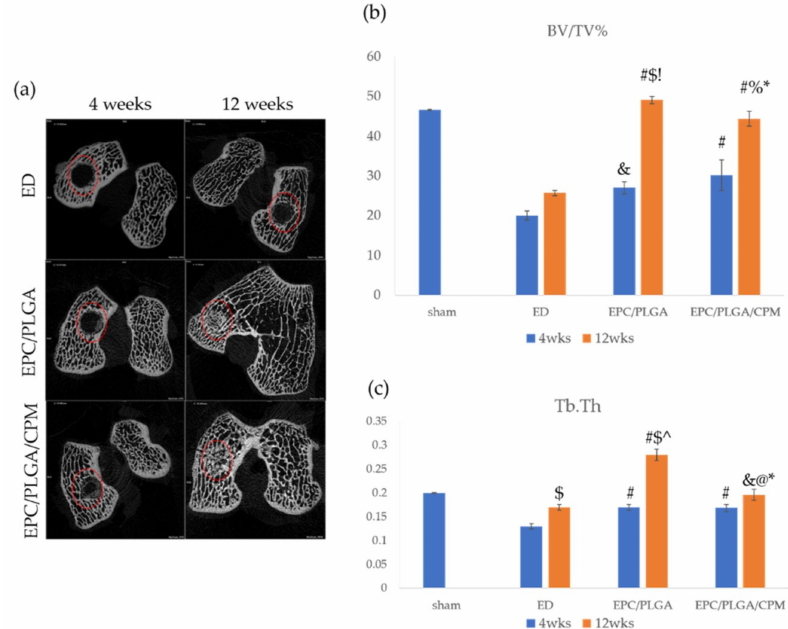
Figure 4. Bone regeneration over time. Bone assessment of 2D micro-CT images, the red dotted circles indicate the defect sites. ( a ); ratio of bone volume to tissue volume (BV/TV) ( b ); and thickness of trabecular bone (Tb.Th) ( c ). *: compared to 4 weeks post-operation ( p < 0.05); $: compared to 4 weeks post-operation, ( p < 0.01); &: compared to ED at the same time point ( p < 0.05); #: compared to ED at the same time point ( p < 0.01); %: compared to EPC/PLGA at the same time point ( p < 0.05); @: compared to EPC/PLGA at the same time point ( p < 0.01); !: compared to sham at 12 weeks, ( p < 0.05); ˆ: compared to sham at 12 weeks ( p <